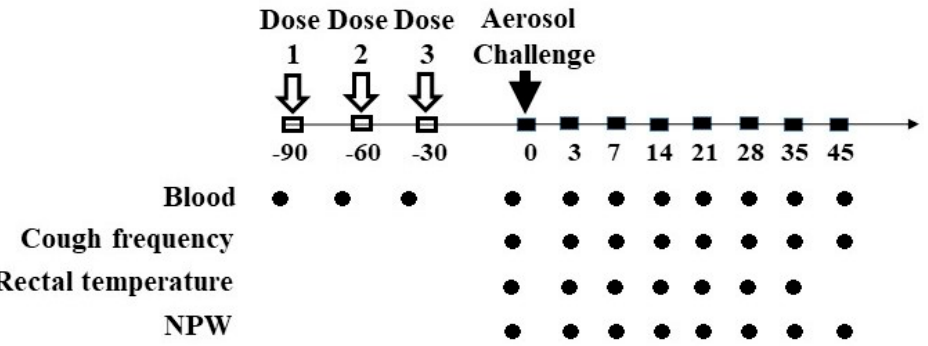
Figure 1. Timeline of vaccination, B. pertussis aerosol challenge, and sample collection from rhesus macaques. Infant rhesus macaques were vaccinated with different vaccines at − 90, − 60, and − 30 days with 0-, 1-, and 2-month schedules and were infected with B. pertussis by aerosol challenge on day 0 (hollow arrow). Blood samples were collected before and 30 days after each immunization, before aerosol challenge, and at days 3, 7, 14, 21, 28, 35, and 45 after challenge. The cough frequency, WBC count, and NPW were determined before aerosol challenge and at days 3, 7, 14, 21, 28, 35, and 45 after challenge. The rectal temperature in each group was measured before aerosol challenge and at days 3, 7, 14, 21, 28, and 35 after challenge.